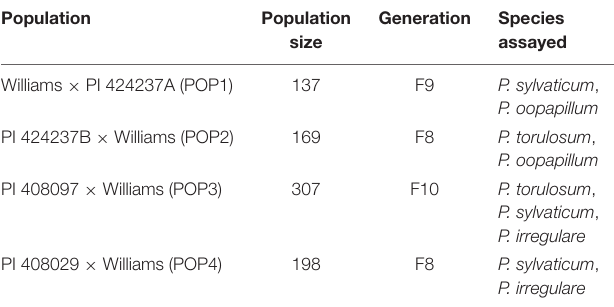
TABLE 1 | Summary of four populations of soybean assessed for their response to species of Pythium in a seed rot assay. Population Population size